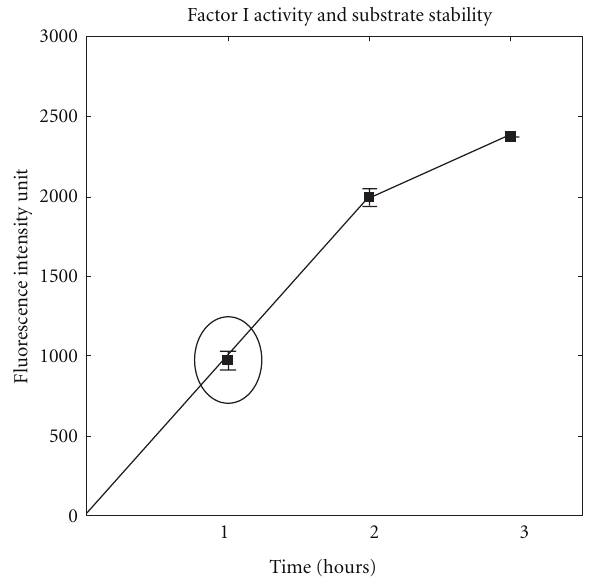
Figure 1: Fluorescence intensity of release of 7-amino-4-methyl coumarin as a function of plasma incubation period ( mean ± SD ; 1h ( 974 ± 44 . 2 ), 2h ( 1995 ± 45 . 2 ) and 3h ( 2374 ± 1 . 2 )).